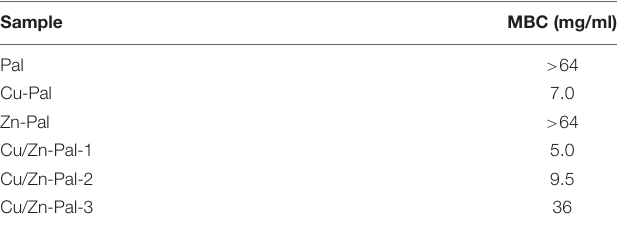
TABLE 3 | The minimum bactericidal concentration (MBC) of the different complexes.